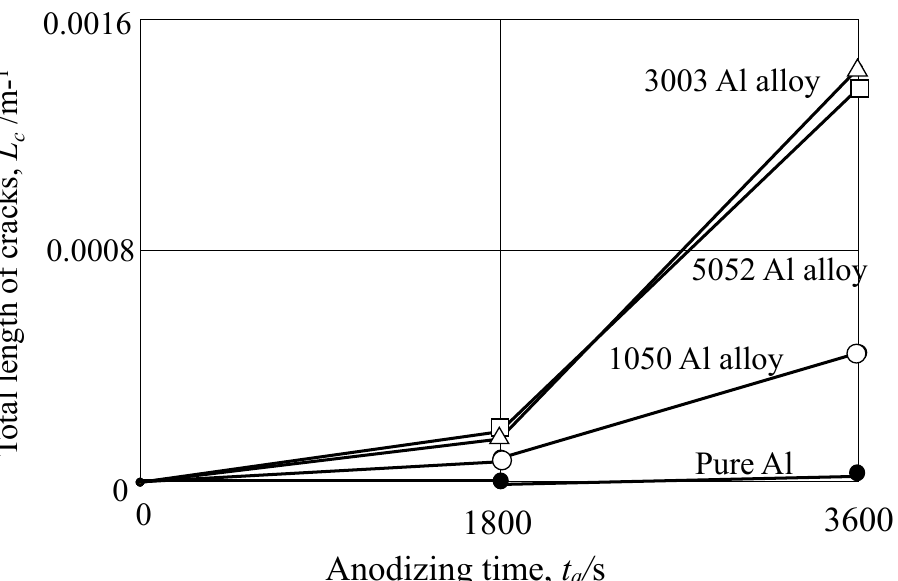
Figure 15. Relationship between the total length of cracks, L c : m/m 2 and anodizing time, t a , obtained for pure Al, 1050-Al alloy, 3003-Al alloy, and 5052-Al alloy. Anodizing condition is described in Figure 3, and pore sealing condition is described in Figure 9.